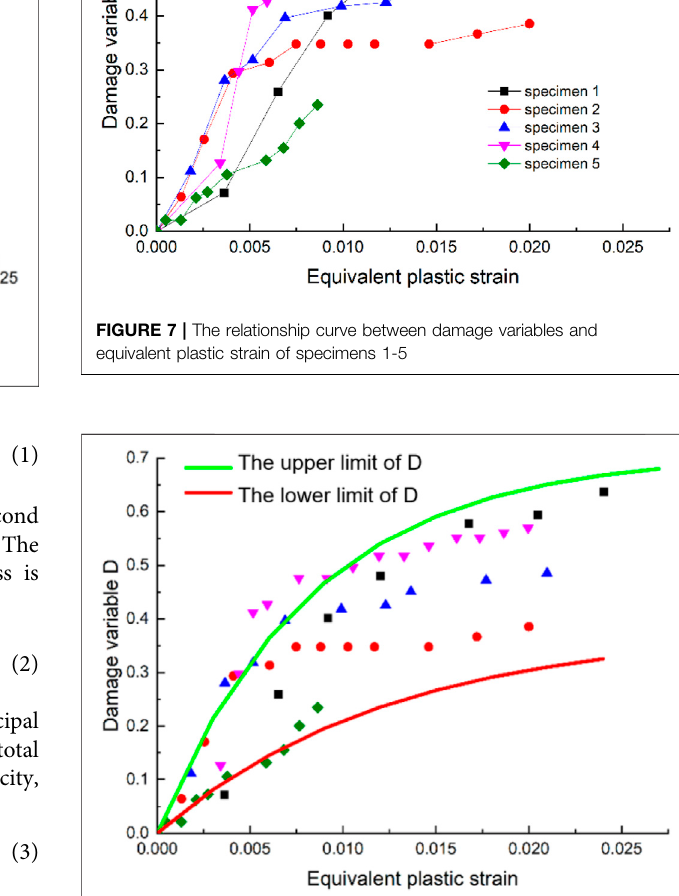
FIGURE 8 | The upper and lower limit curves regarding the damage variables of specimens